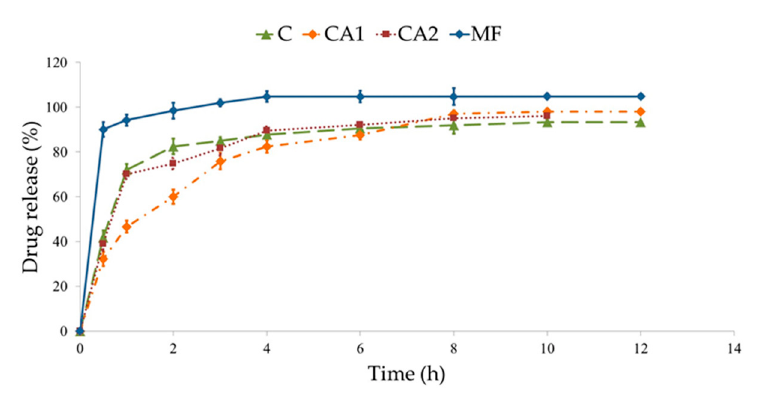
Figure 5. MF dissolution from non-modified microparticles C, cross-linked CA1, CA2, and commercial product used as a control (MF).